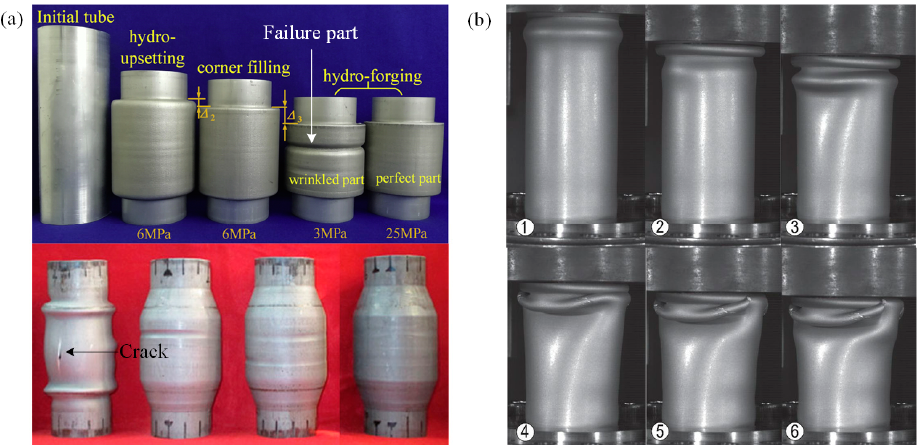
Figure 16. Forming by deformation instability: ( a ) forming of variable-diameter tube [192,193]; ( b ) tube forming with axial compression, and analyzing the degree of deformation instability in the six-step ( ①-⑥ ) compression process [194].